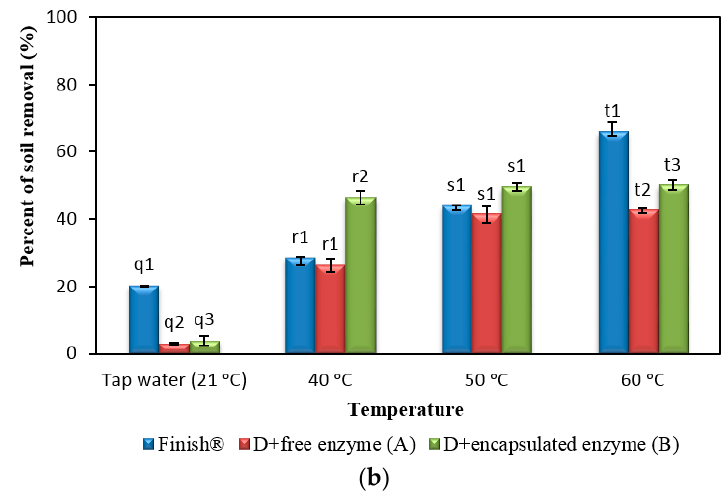
Figure 5. Comparison of dishwashing performance of the formulated detergents A (contained free enzymes) and B (contained encapsulated enzymes) with commercial ADD, Finish ® in ( a ) Soft water (0 ppm CaCO 3 ) and ( b ) Hard water (350 ppm CaCO 3 ) at 21 °C, 40 °C, 50 °C and 60 °C. Note: Superscripts m2 and m3 (for test in 21 °C soft water), n2 and n3 (for test in 40 °C soft water), o2 (for test in 50 °C soft water), q2 and q3 (for test in 21 °C hard water), r2 (for test in 40 °C hard water), t2 and t3 (for test in 60 °C hard water) showed significant difference between the groups of same water temperature. All superscripts were obtained using post-hoc tests as shown in Table S6. Data are means ± standard deviation of three determinations and indicated as error bars.